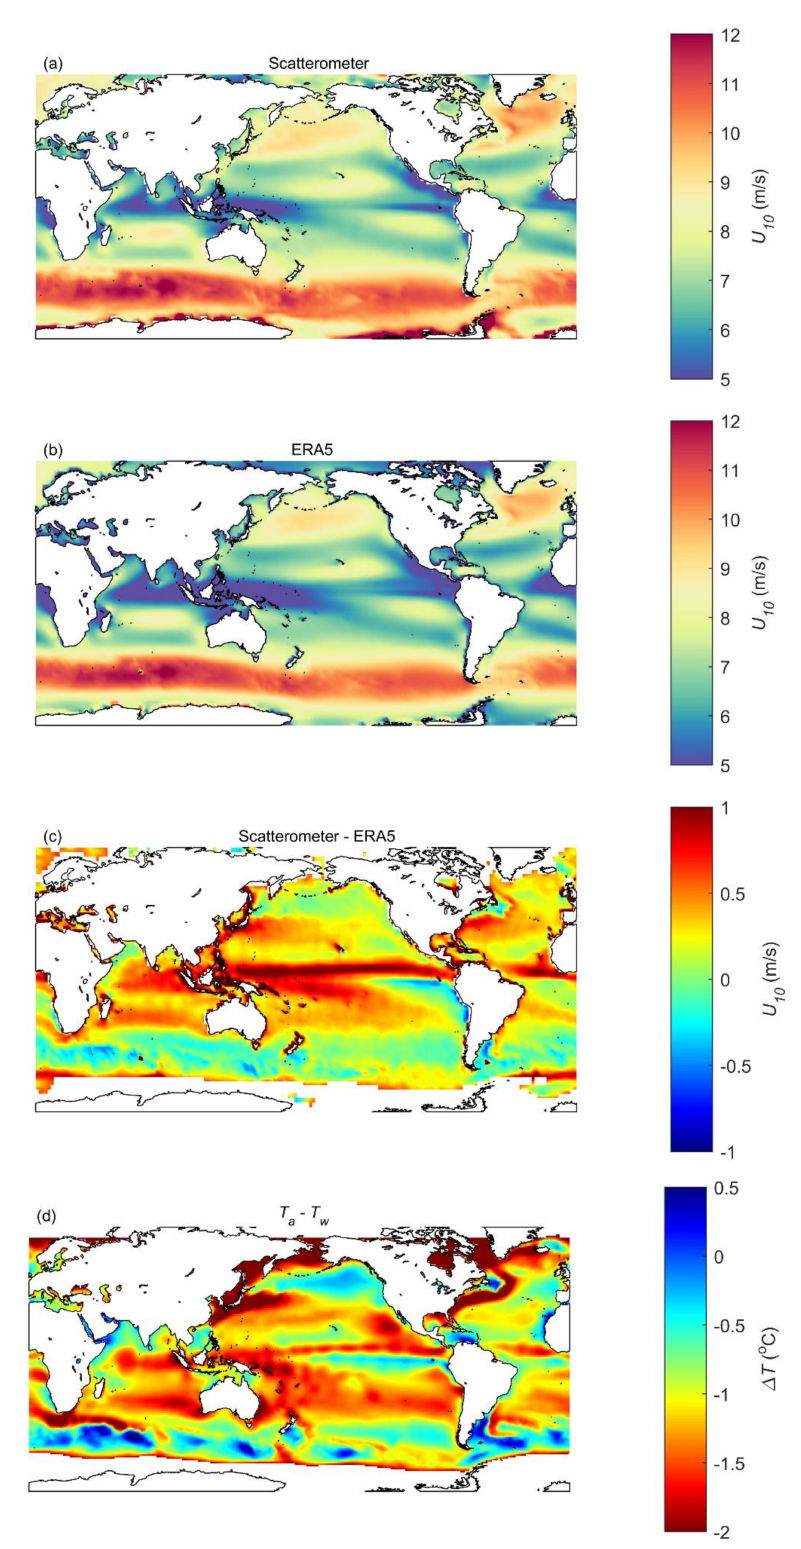
Figure 8. Comparison of mean annual wind speed at a reference height of 10 m. ( a ) Scatterometer wind speed, ( b ) ERA5 wind speed, ( c ) di ff erence between scatterometer and ERA5 U 10 ( Scatt . ) − U 10 ( ERA 5 ) , ( d ) air–water temperature di ff erence, ∆ T = T a − T w